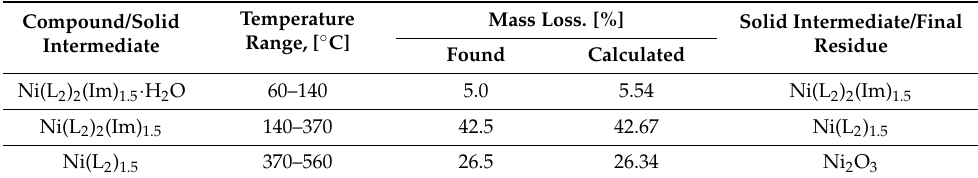
Table 9. TG-DTG analysis data of decomposition of Ni(L 2 ) 2 (Im) 1.5 · H 2